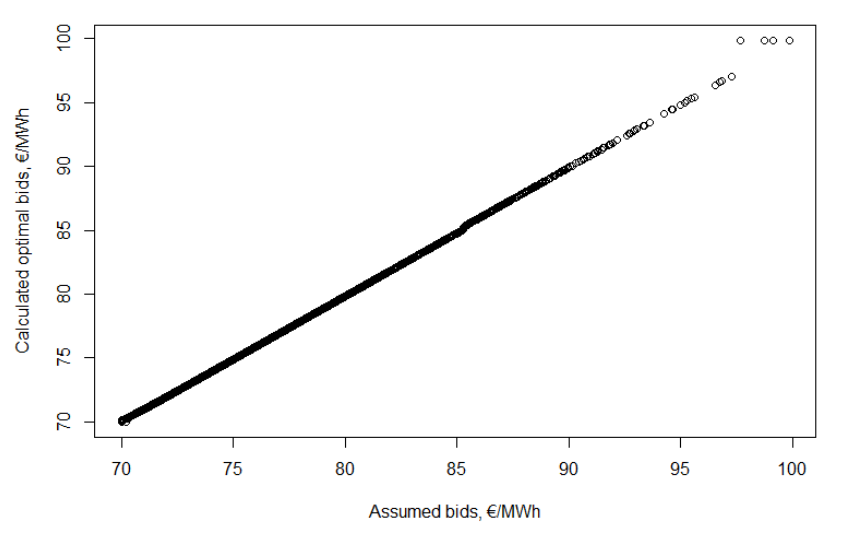
Figure 13. The assumed and the optimal bids for 10,000 valuations, source: own